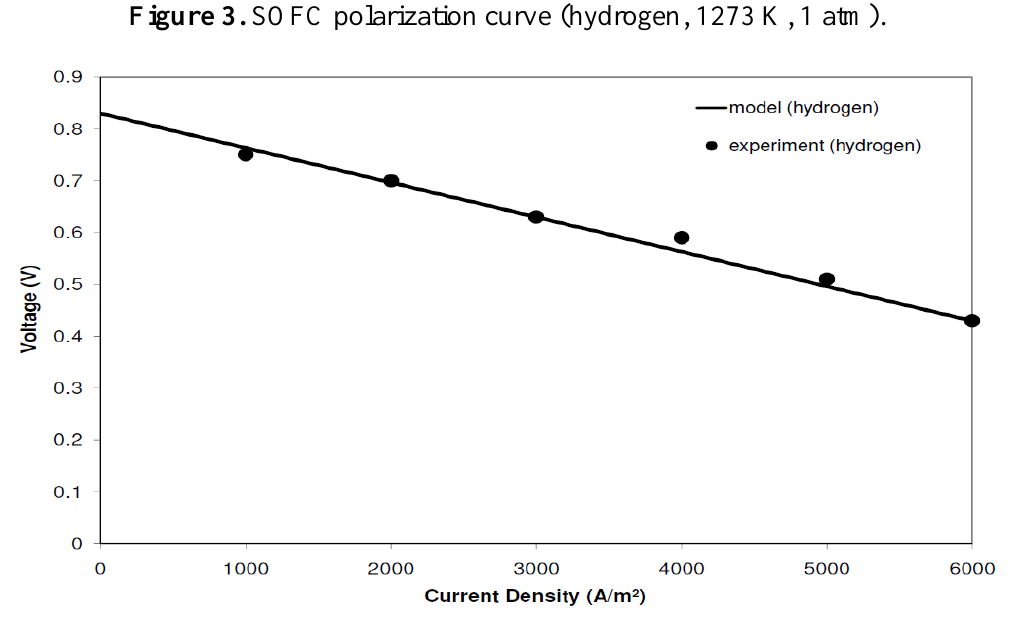
Figure 3. SOFC polarization curve (hydrogen, 1273 K, 1